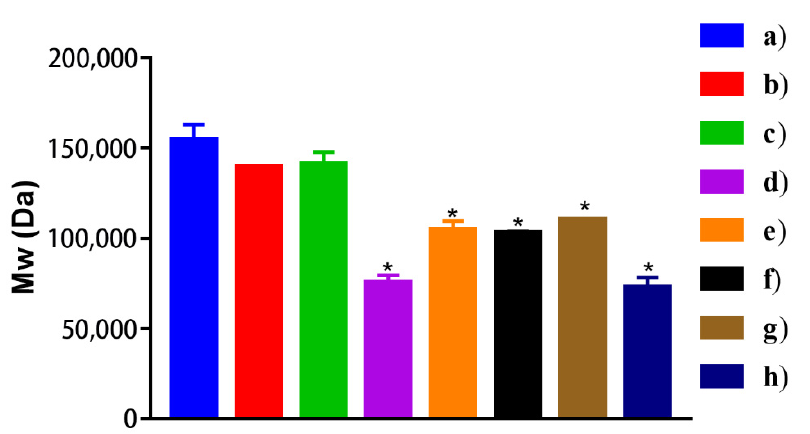
Figure 5. Mw of organic phase with different mixing procedures. Group a: only PLGA; group b: PLGA was dissolved in EA; group c: PLGA was dissolved in EA and BA; group d: PLGA and NTX were dissolved together in the mixture of EA and BA; group e: PLGA was dissolved in